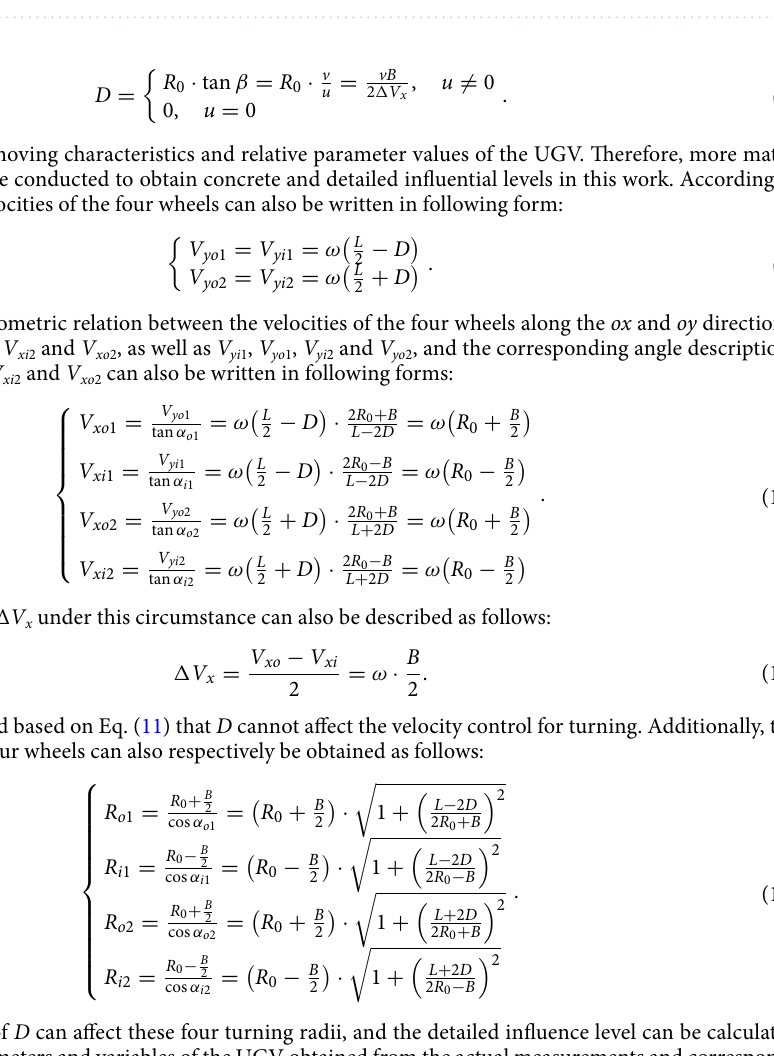
Figure 2. ( a ) A designing diagram using SolidWorks, ( b ) actual UGV used in this